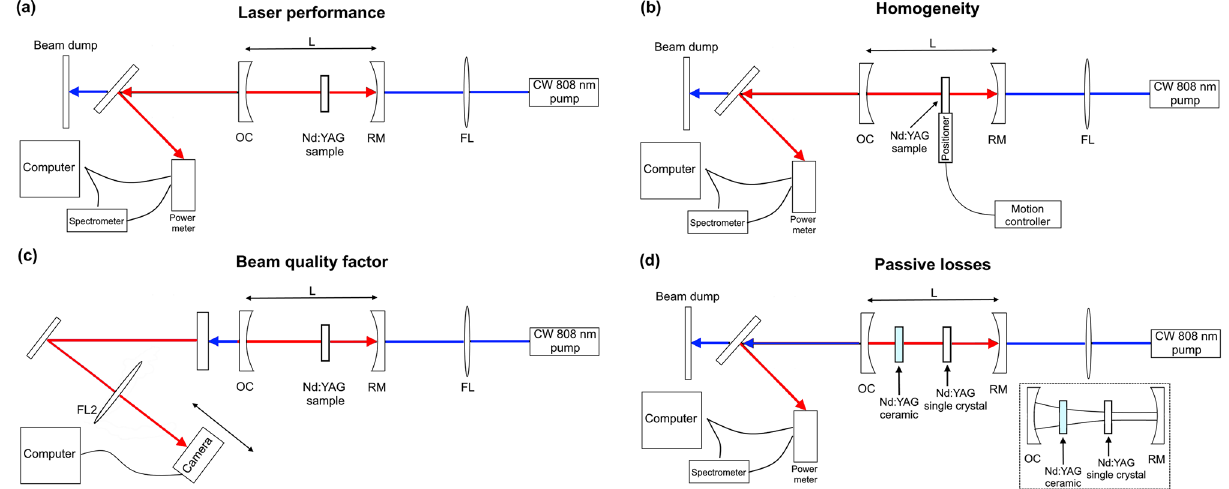
Figure 1. Schematic of the optical setup used for characterization of ( a ) laser performance (efficiency and threshold), ( b ) homogeneity and ( c ) M 2 beam quality factor ( d ) passive